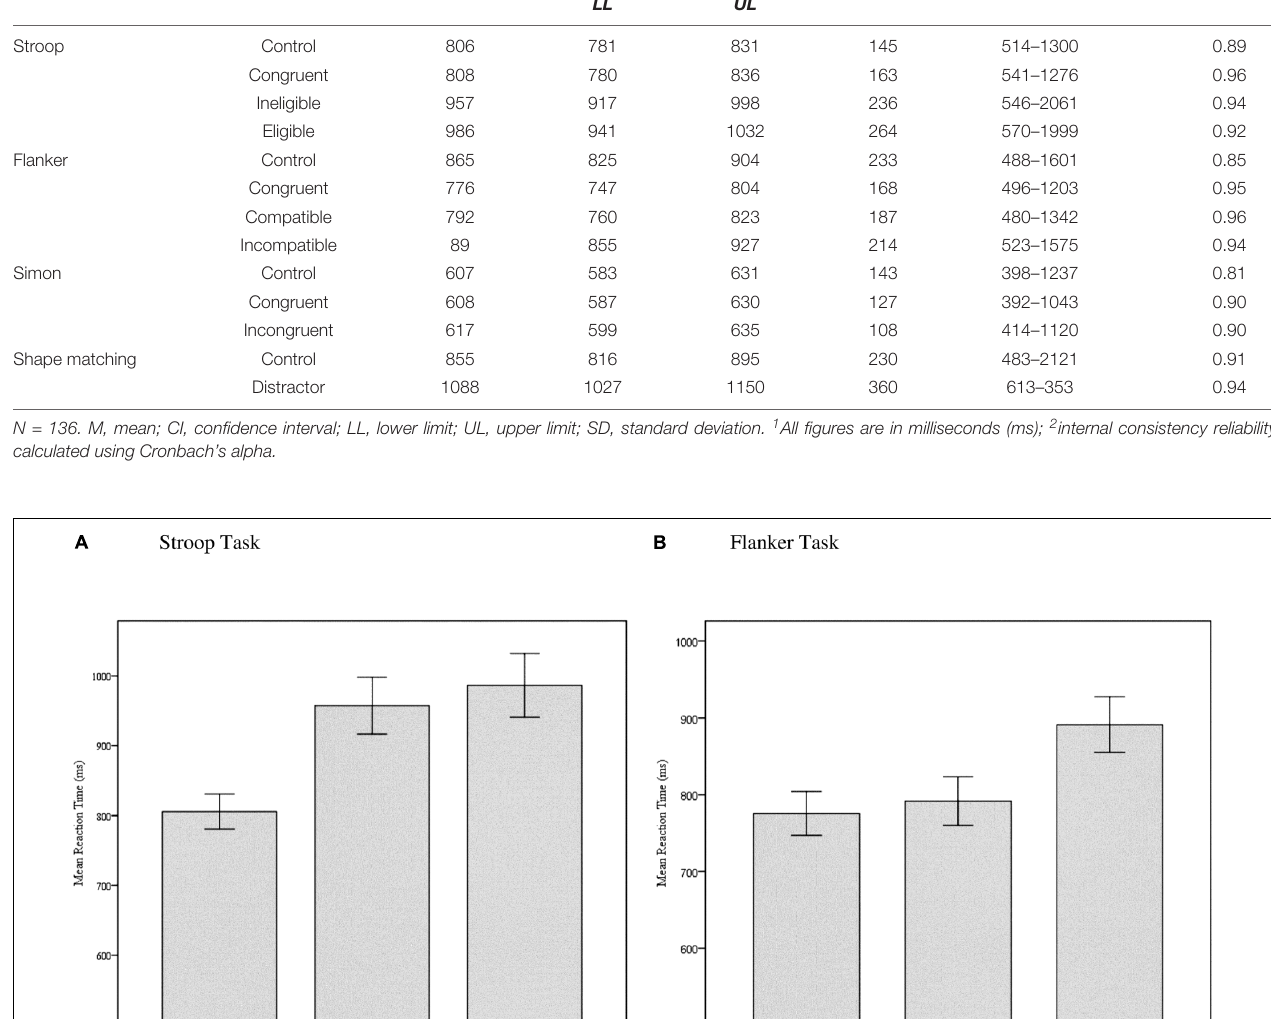
Frontiers in Psychology |